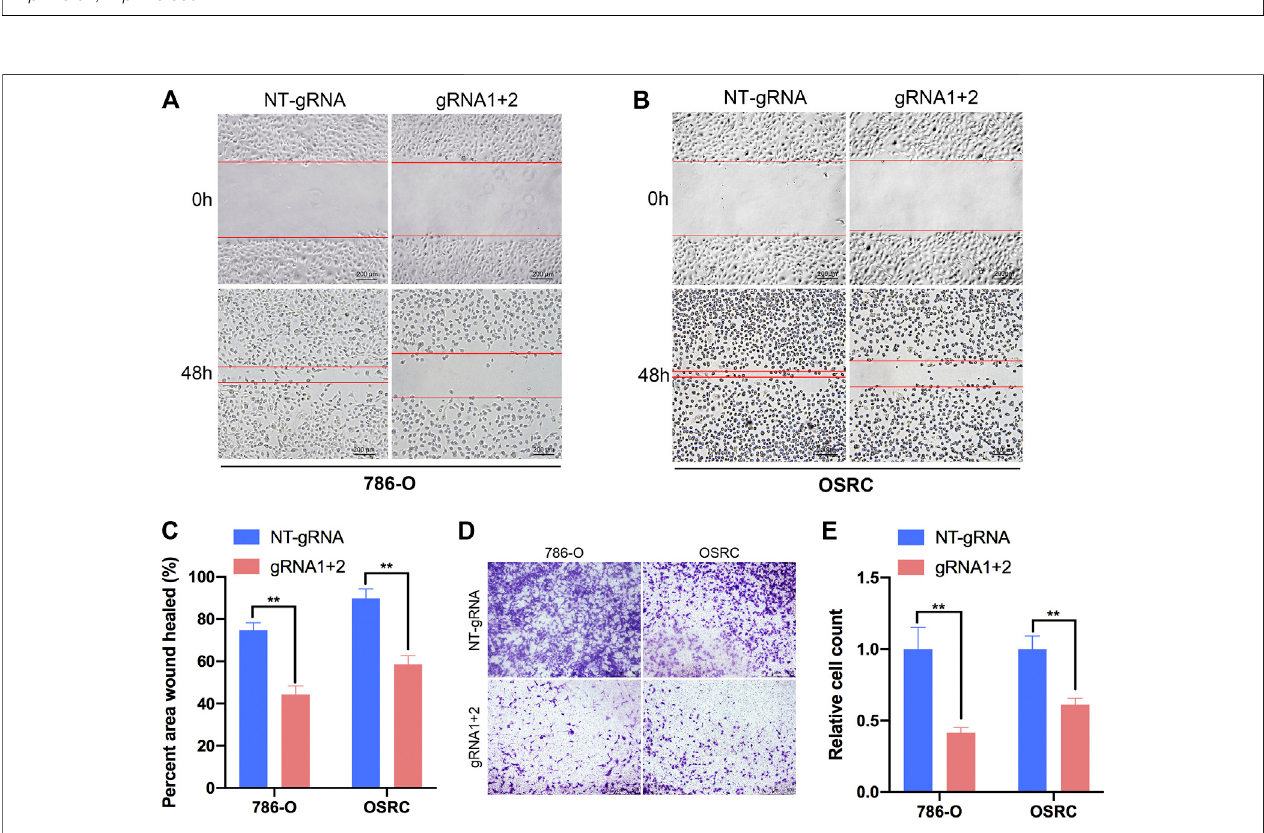
FIGURE 5 | Targeting m 6 A of PLOD2 transcripts by dm 6 ACRISPR inhibited RCC cells migration. (A – C) Wound healing assays of 786-O and OSRC cells after transfected with dCas13b-ALKBH5 and sgRNAs. (D,E) Transwell migration assays of 786-O and OSRC cells after transfected with dCas13b-ALKBH5 and sgRNAs. ** p <